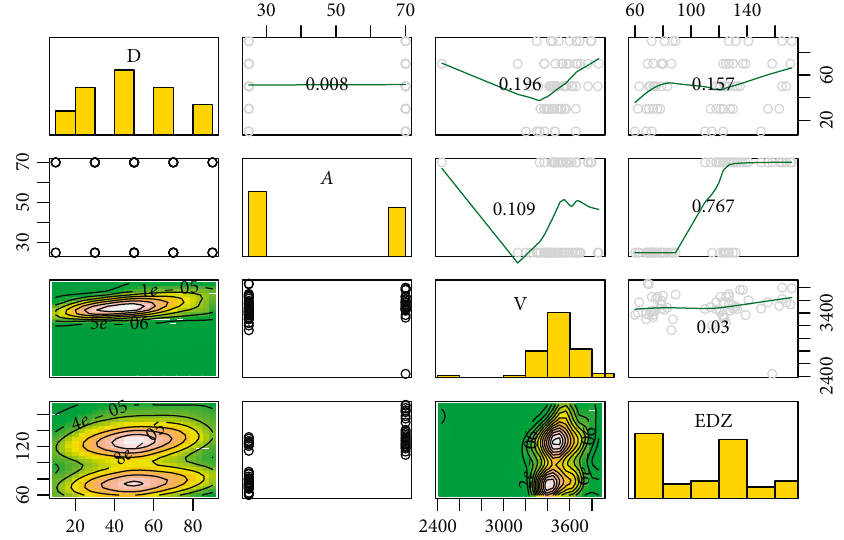
Figure 11: Correlation matrix plot of the original